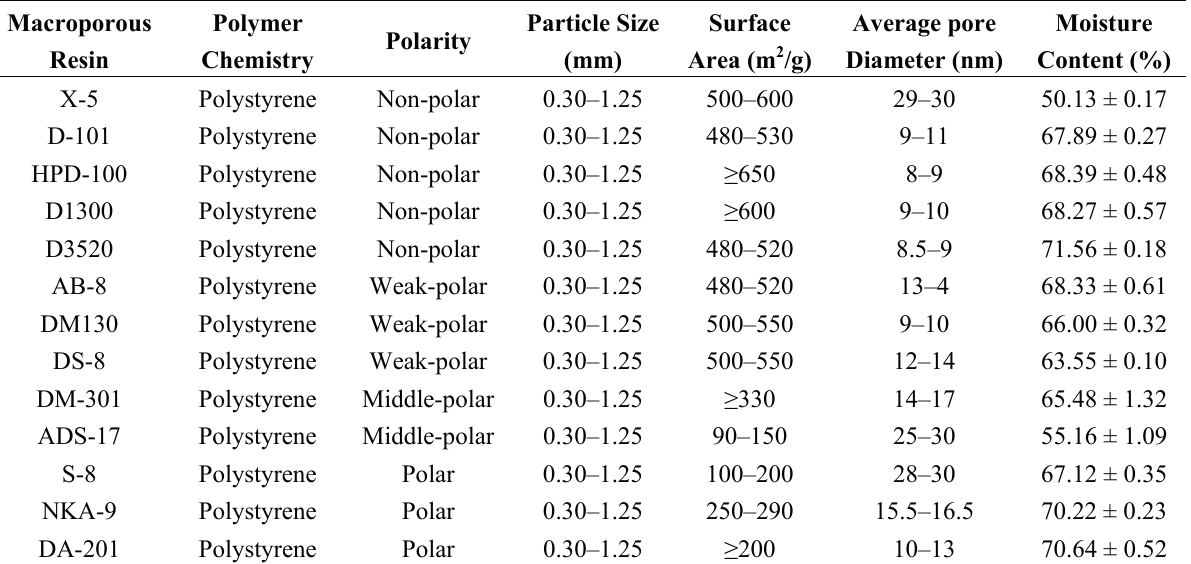
Table 4. Chemical and physical properties of the macroporous resins